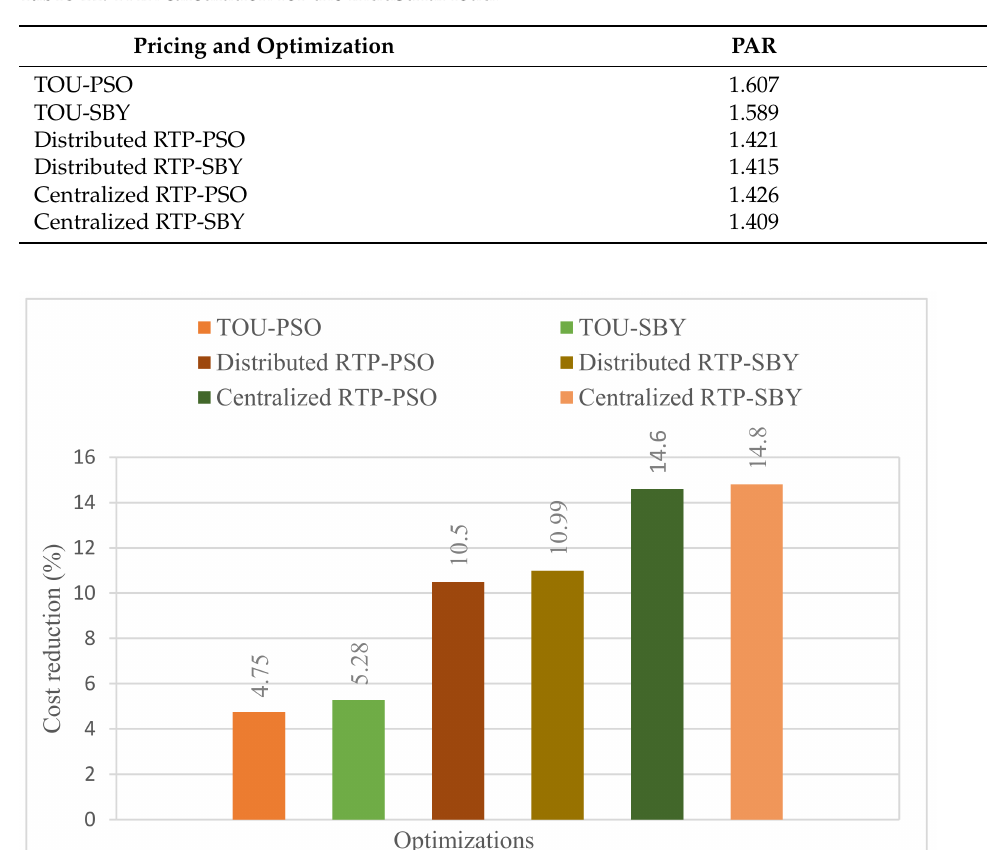
Table 11. PAR calculation for the industrial load.